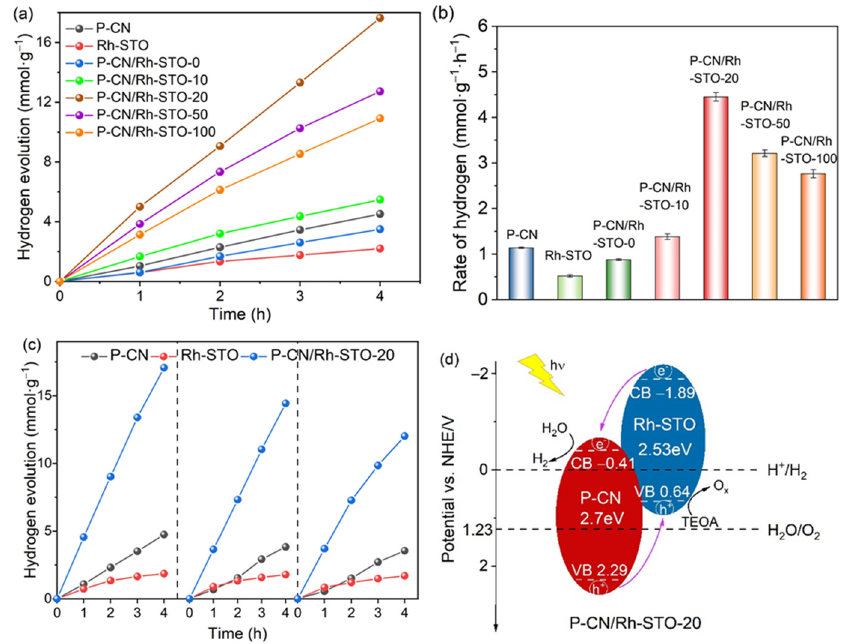
Figure 6. ( a ) Photocatalytic H 2 evolution over P-CN, Rh-STO and the series of P-CN/Rh-STO samples (1 wt% Pt was used as cocatalyst); ( b ) the rate of hydrogen production of P-CN, Rh-STO, and the series of P-CN/Rh-STO samples; ( c ) cycle experiments of the photocatalytic H 2 generation over P-CN, Rh-STO, and P-CN/Rh-STO-20; ( d ) schematic diagram of charge transfer in